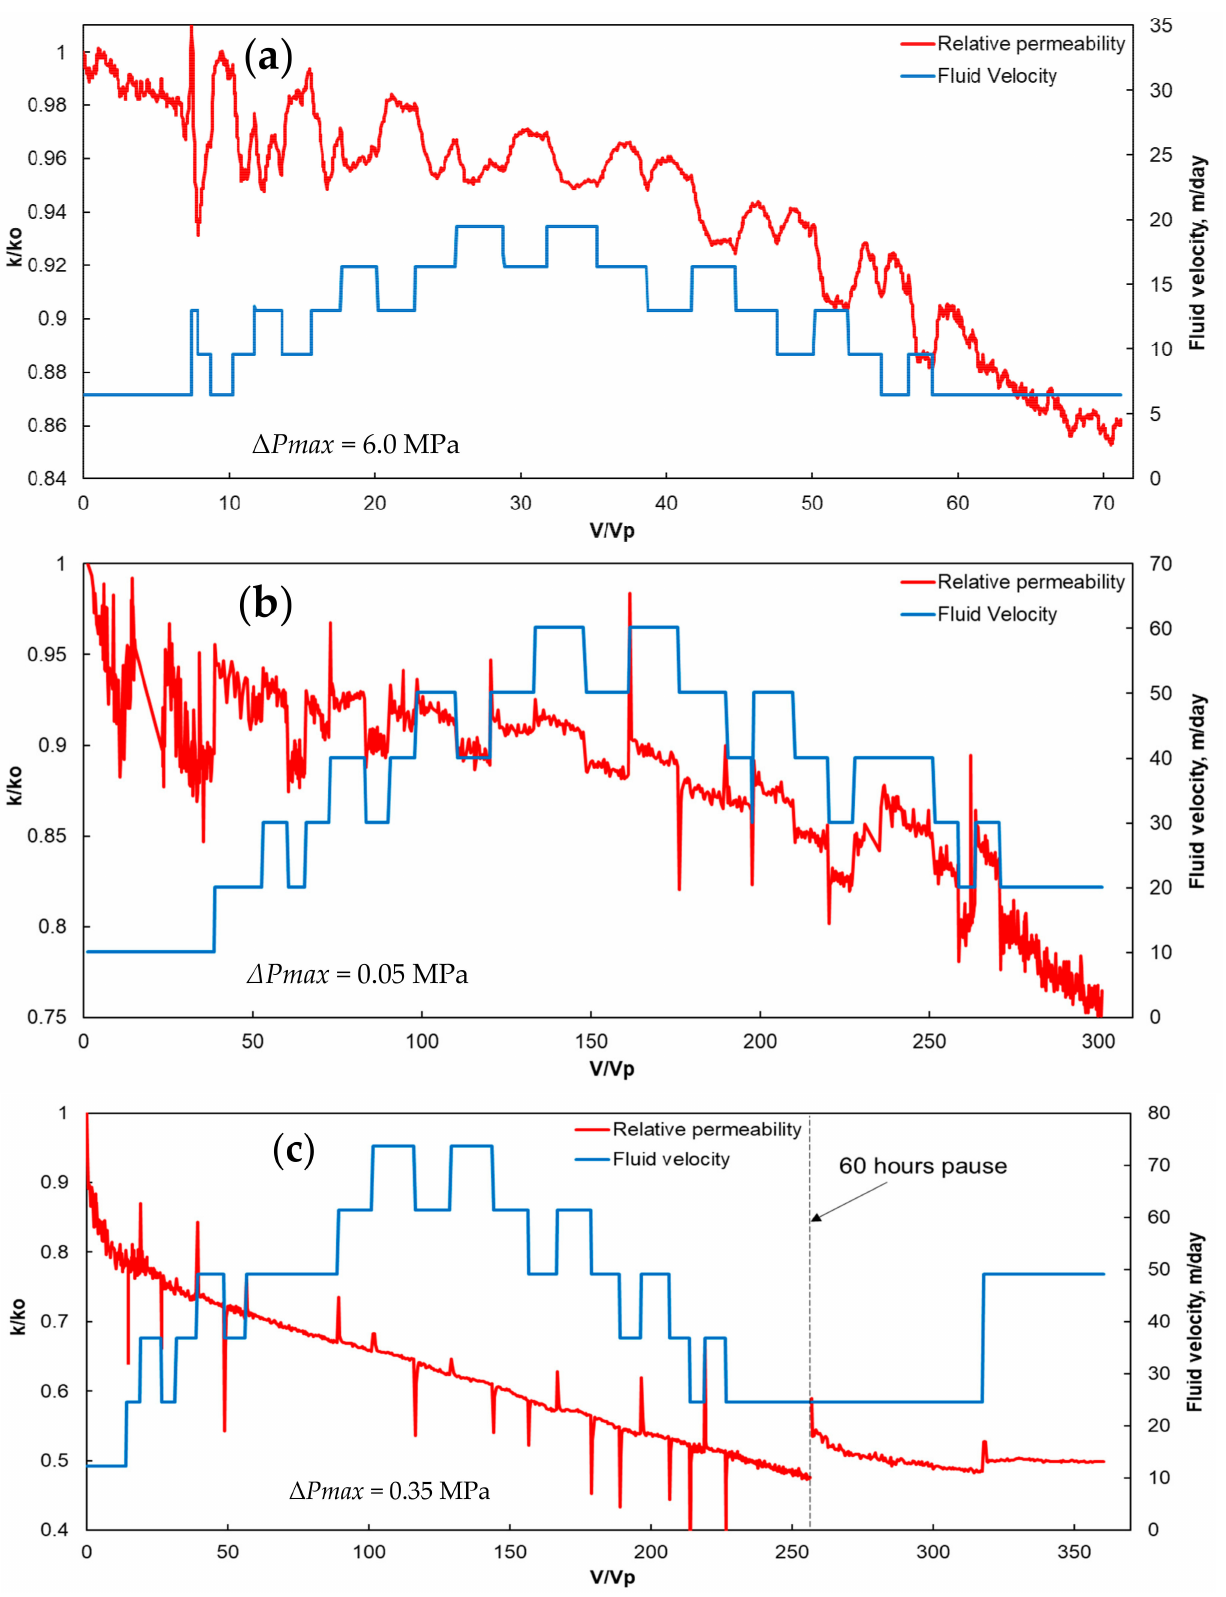
Figure 4. Change in relative permeability of samples IEKEV2517 ( a ), IEKEV7483 ( b ) and IEKEV5602 ( c ). The confining pressure is 45 MPa, the pore pressure is 18 MPa. ( c ) The dotted line shows the 60-h injection pause during which the sample was held at constant pore and confining